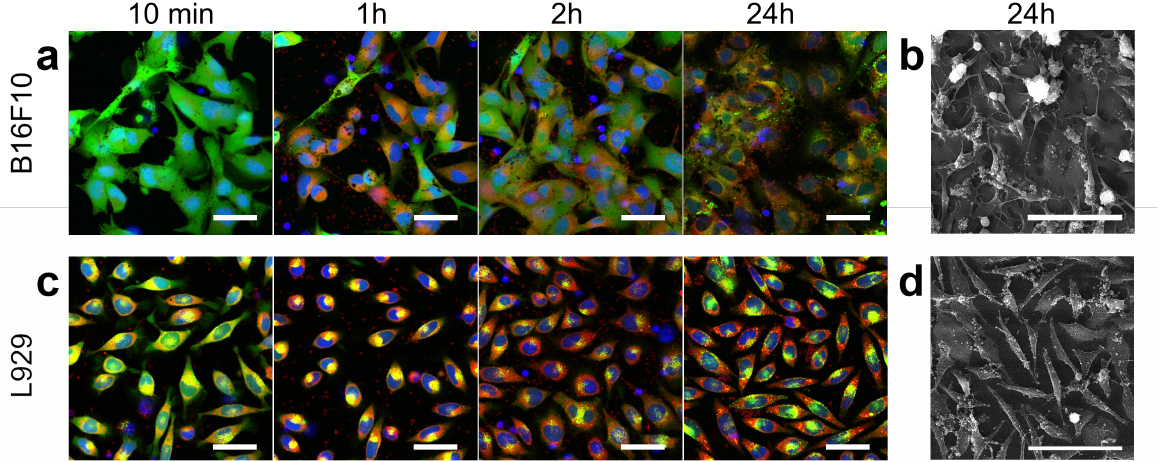
Figure 4. Microscopy of adherent cell cultures incubated with platelets for 24 h. Fluorescence microscopy of B16F10 ( a ) and L-929 ( c ) during incubation with platelets. Blue, green, and red colors correspond to Hoechst (nucleus), Calcein AM (cytoplasm), and Nile Red (preliminary staining of isolated platelet membrane) staining, respectively. All cells were stained before adding platelets and no restaining was performed 24 h later. Scale bars are 20 µ m. Scanning electron microscopy of ( b ) B16F10 and ( d ) L-929 after 24 h of incubation with platelets. Scale bars are 100 µ